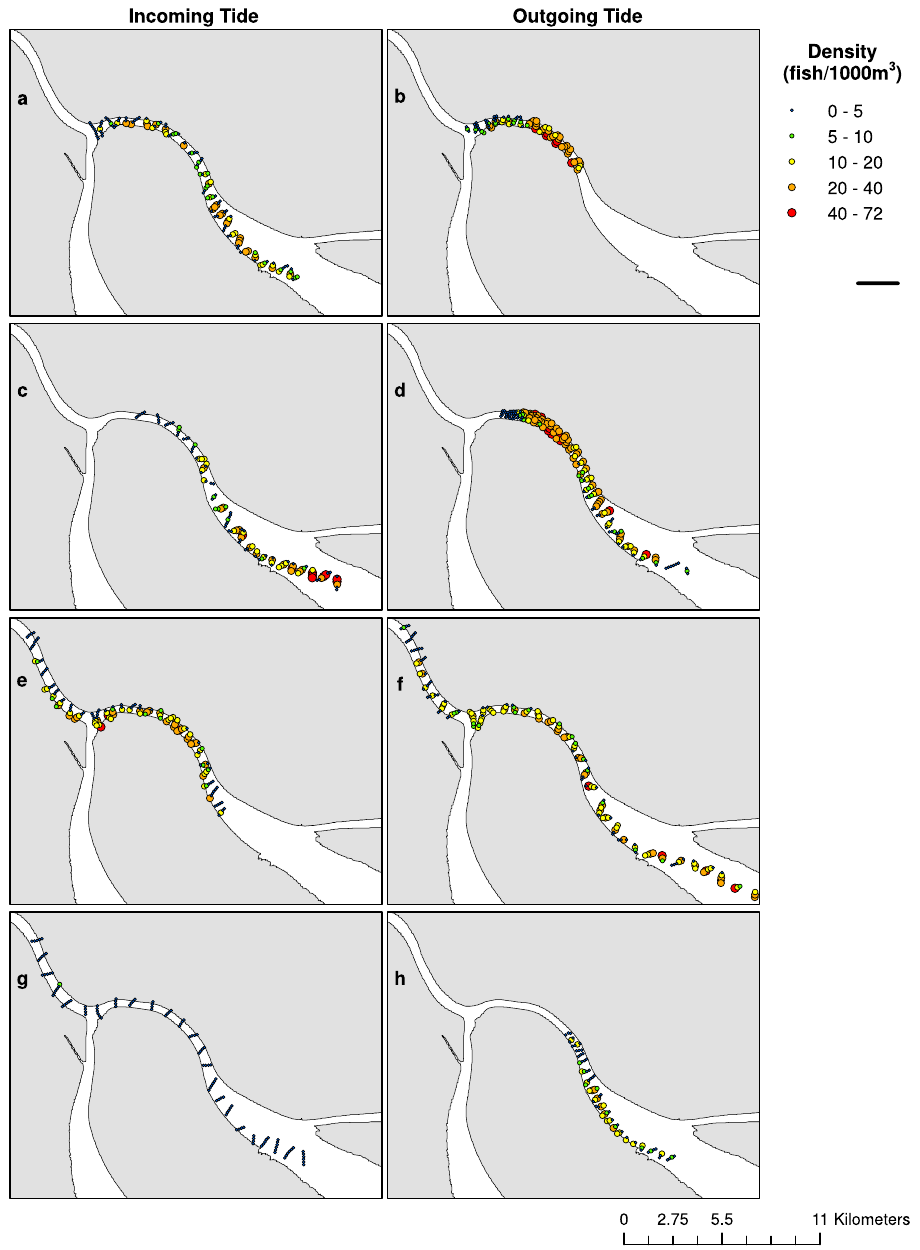
Figure 3. Spatial distribution of Gulf Corvina ( Cynoscion othonopterus ) densities (fish/1000 m 3 ). Mean fish densities per every 150-m survey length in the spawning grounds of the northeastern channel of the Colorado River Delta on the incoming and outgoing tides on ( a , b ) 27 March 2014, ( c , d ) 28 March 2014, ( e , f ) 27 April 2014, and ( g , h ) 28 April 2014. All survey data are depicted, including 150-m survey lengths with densities of 0 fish/1000 m 3 . Collection of active acoustic data on the outgoing tide of 27 March 2014 ( b ) ended prior to the termination of passive acoustic data collection due to deteriorated survey conditions. Maps were generated using the ArcMap extension of ArcGIS version 10.2.2 (http://www.esri.com/, ESRI,